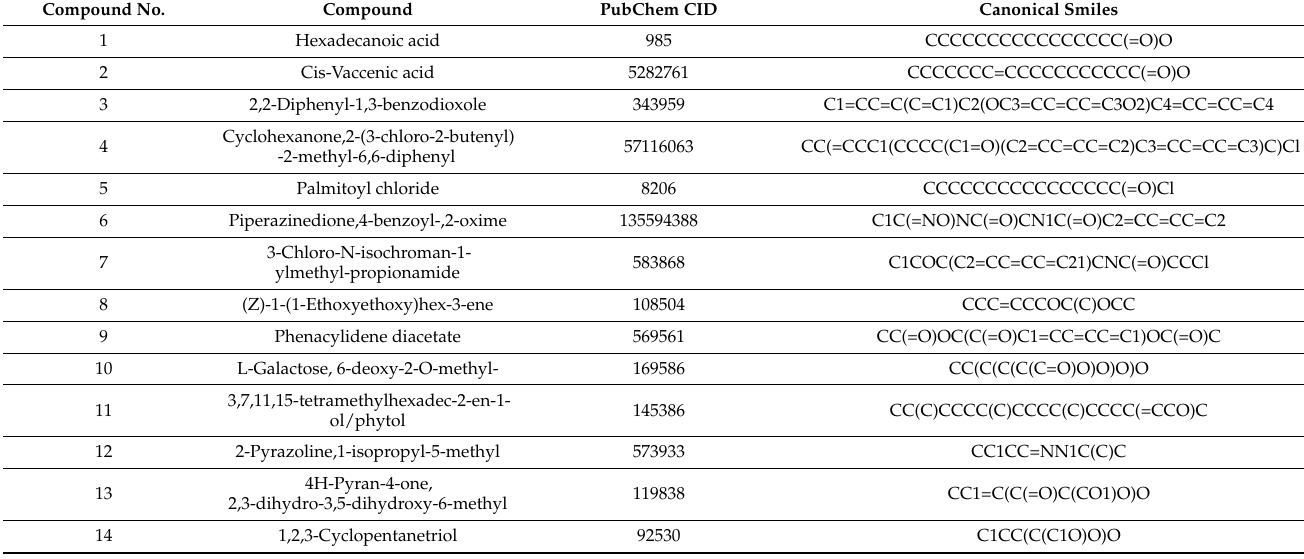
Table 1. Canonical smiles of selected